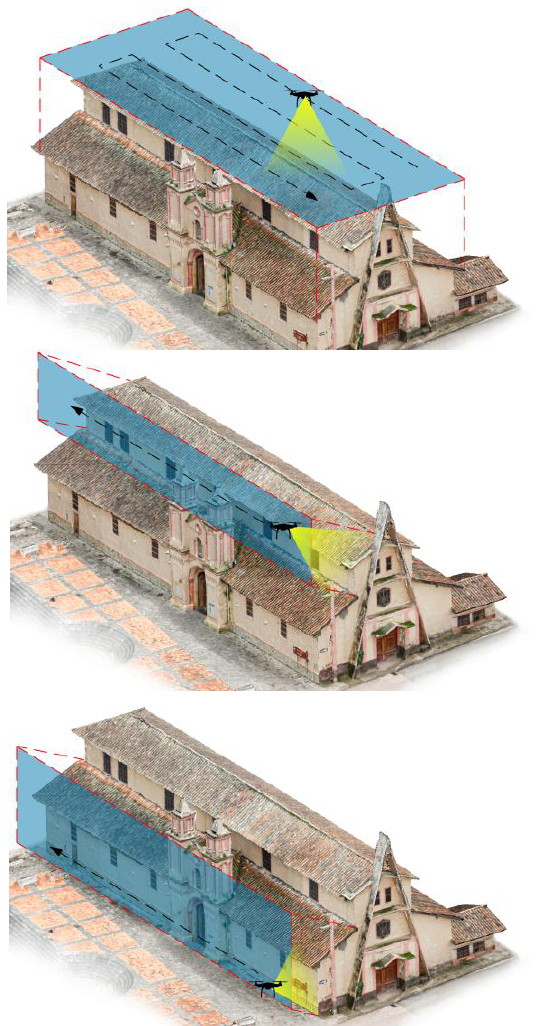
Figure 6 . Flight plans with